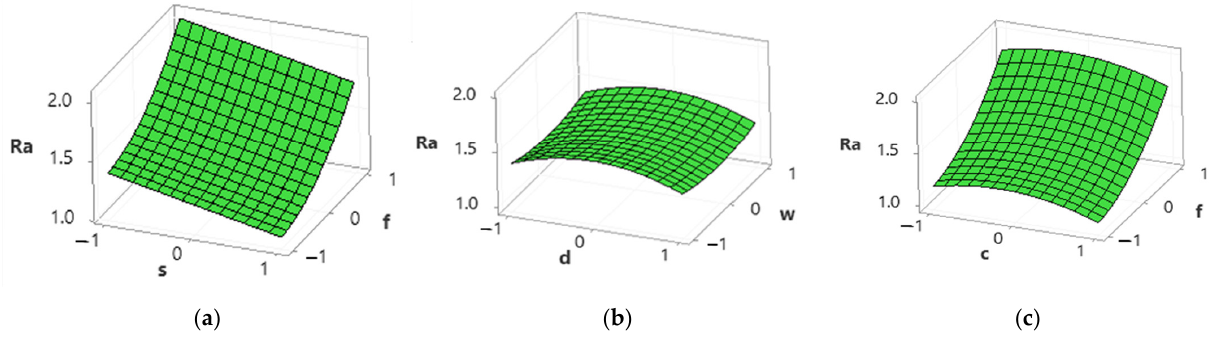
Figure 6. Surface plots for average surface roughness. ( a ) Spindle speed vs. feed rate; ( b ) depth of cut vs. width of cut; ( c ) cutting conditions vs. feed rate.